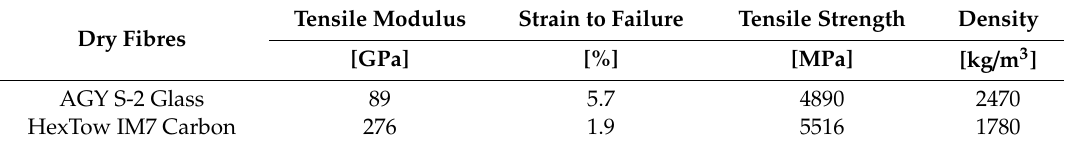
Figure 1. Geometry and dimensions of the specimens. The grey-coloured areas in the top view are the gripping areas covered by sandpaper. The side view shows the layup structure of the interleaved hybrid composite. The baseline configuration follows the same structure, without the interleaf layer. Table 1. Mechanical properties of the dry fibres and the epoxy resin based on manufacturer’s data.